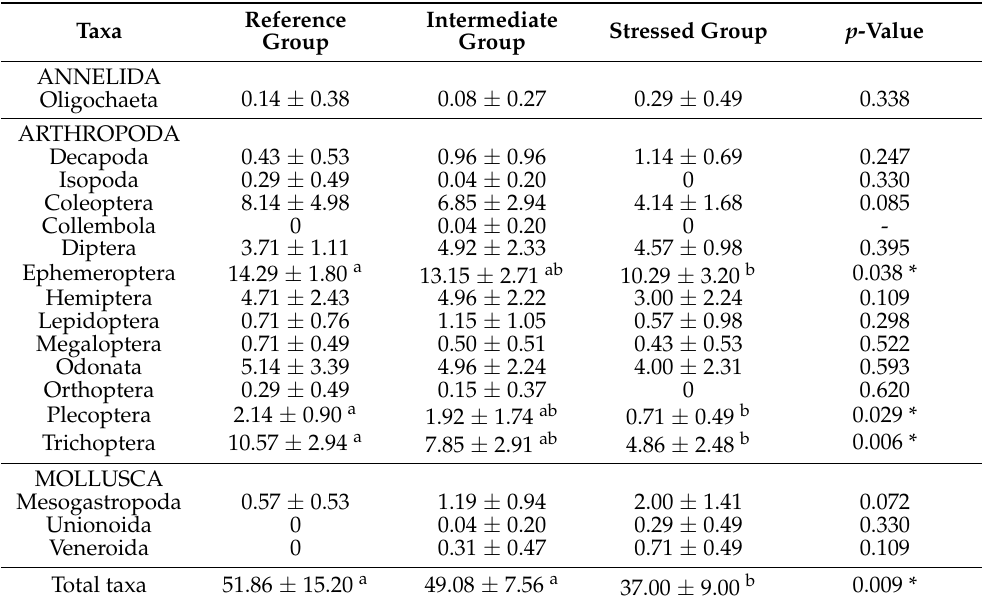
Table 3. Numbers of benthic macroinvertebrate taxa found in reference, intermediate, and stressed sites. Data are expressed as Mean ± SD.